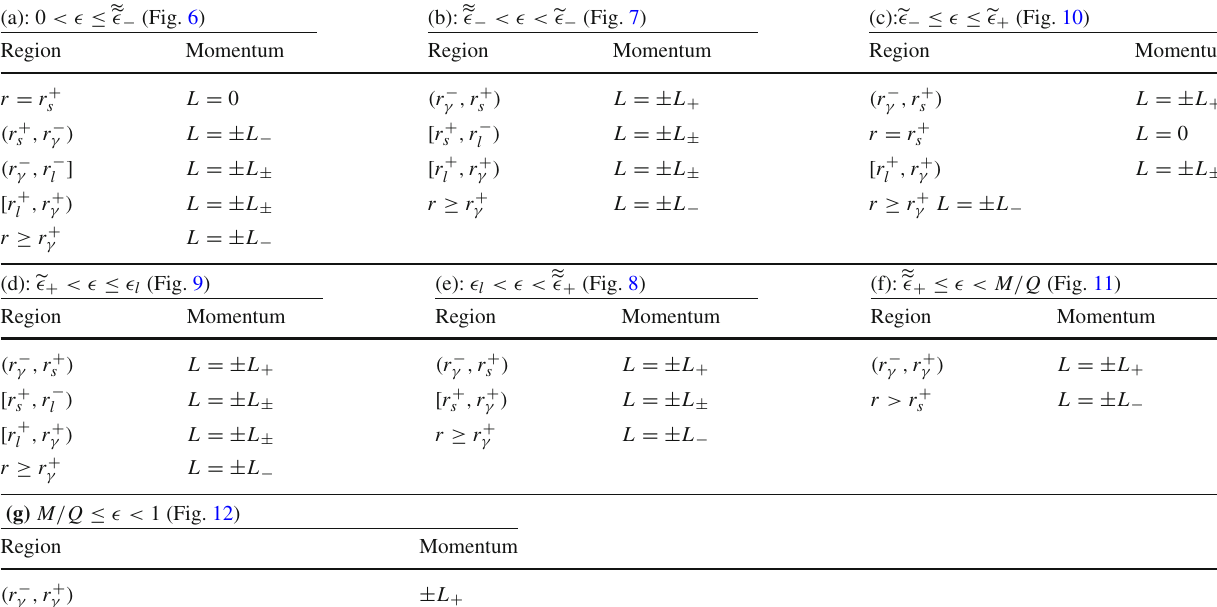
Table 5 Class I + < : M < Q ≤ 5 /( 2